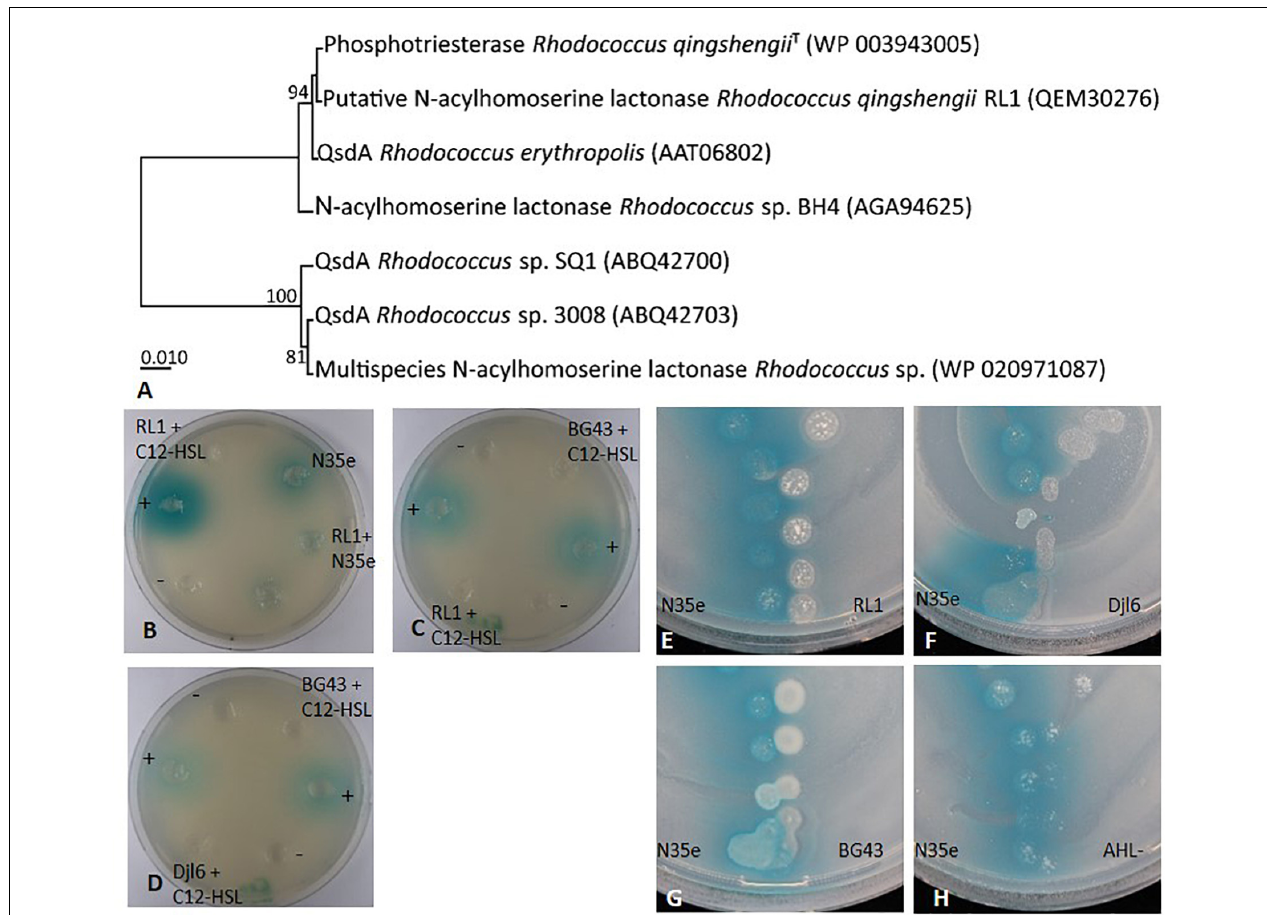
FIGURE 7 | AHL degradation and quorum quenching by Rhodococcus strains RL1, djl6, and BG43. (A) UPGMA phylogenetic tree of translated qsdA (quorum-sensing signal degradation) gene of RL1 and related sequences from Rhodococcus strains. The percentage of replicate trees in which the associated taxa clustered together in the bootstrap test (1000 replicates) are shown next to the branches. The evolutionary distances were computed using the Poisson correction method. All ambiguous positions were removed for each sequence pair (pairwise deletion option). There were a total of 323 positions in the final dataset. Evolutionary analyses were conducted in MEGA X (Kumar et al., 2018). (B–D) Well-diffusion plate assays on NB plates all supplemented with the sensor strain A136 and X-Gal. Except for the cultures containing AHL producing strain A. radicis N35e, C12-HSL was added during cultivation of all bacteria. Supernatants of these cultures were added to the wells and blue color formation by the sensor strain indicated remaining AHL in the tested supernatant. NB with C12-HSL (+) served as positive control, and NB without C12-HSL (–) as negative control. (E–H) V-shaped assays on NB after 30 h supplemented with the sensor strain A136 and X-Gal. AHL negative mutant A. radicis N35e AHL- served as control. Presence of AHLs is detected by the sensor strain Agrobacterium tumefaciens A136 indicated by blue color change of